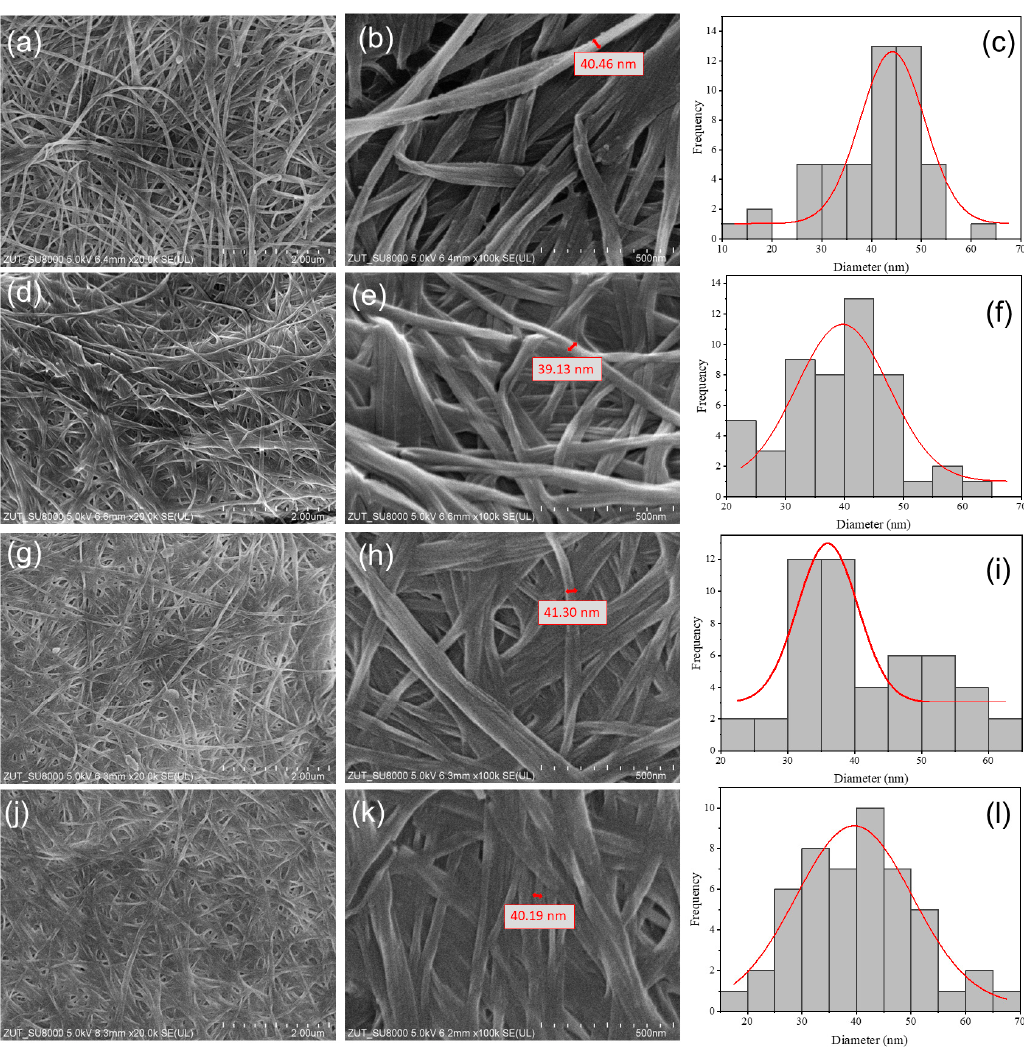
Figure 5. The SEM images of the BC obtained from cultures with different oligo- and polysaccharides as carbon source hydrolysed by specific enzymes at 20,000× (left column), 100,000× (centre column) magnification and distribution of BC microfibrils diameters’ (right column). The BC samples obtained from standard HS medium—( a – c ), medium with sucrose and β -D-Fru—( d – f ), medium with lactose and β -Gal—( g – i ), and from a medium with starch and GLA—( j – l ). The presented SEM images show the BC surface obtained from modified cultivation media with the highest enzymes units amounts.